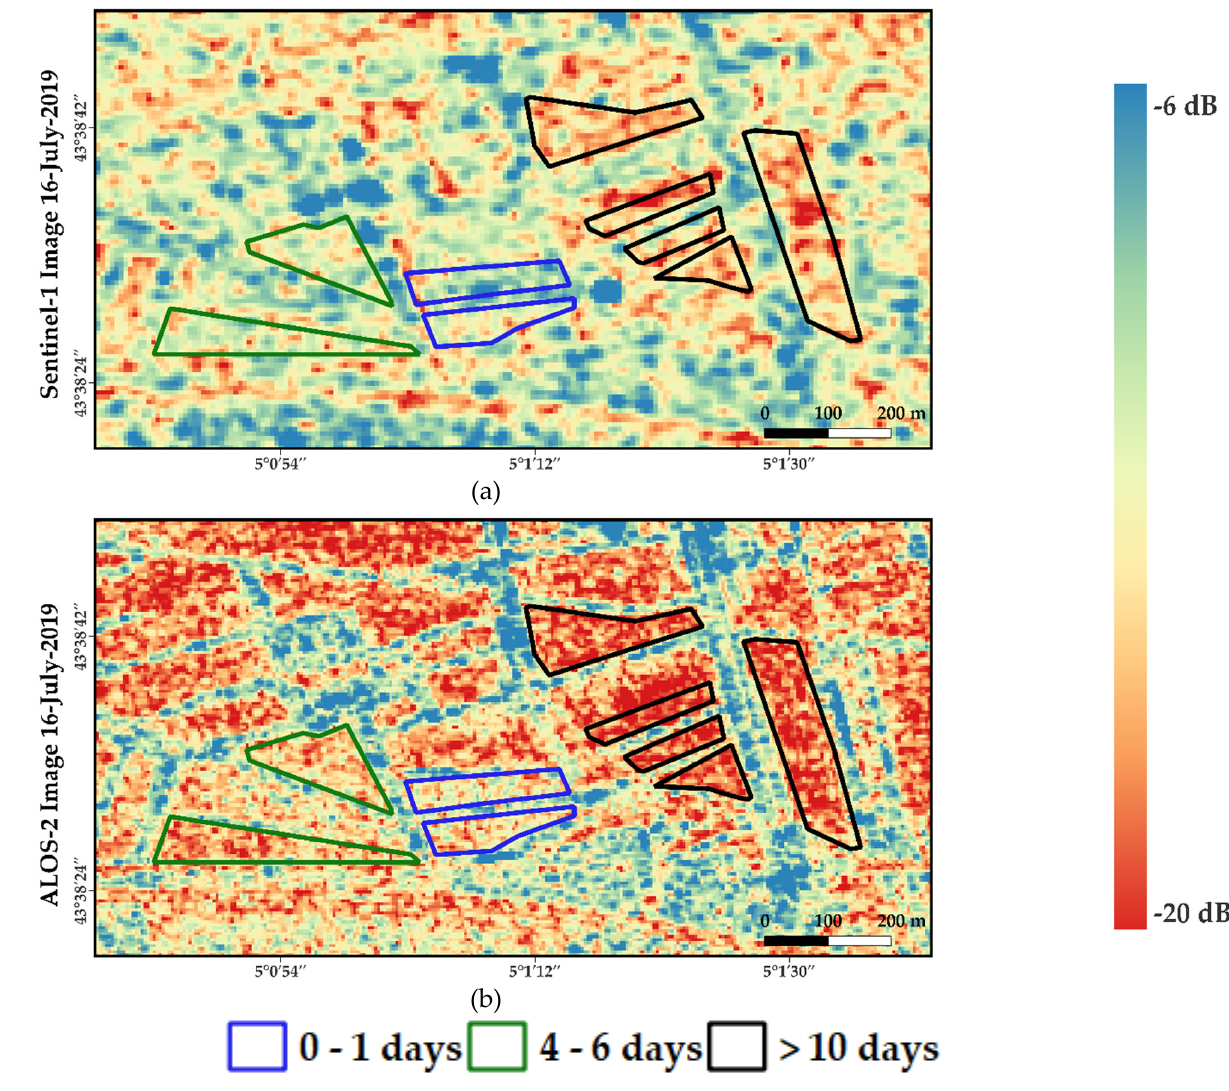
Figure 9. Examples of the differences in the SAR backscattering coefficients for grassland plots as a function of the time difference between the last irrigation event and the SAR acquisition date ( ∆t) on 16/07 for ( a ) S1 C band in VV polarization and ( b ) ALOS-2 L band in HH polarization. Blue, green, and black represent plots with ∆t from 0–1 days, 4–6 days, and more than 10 days, respectively.